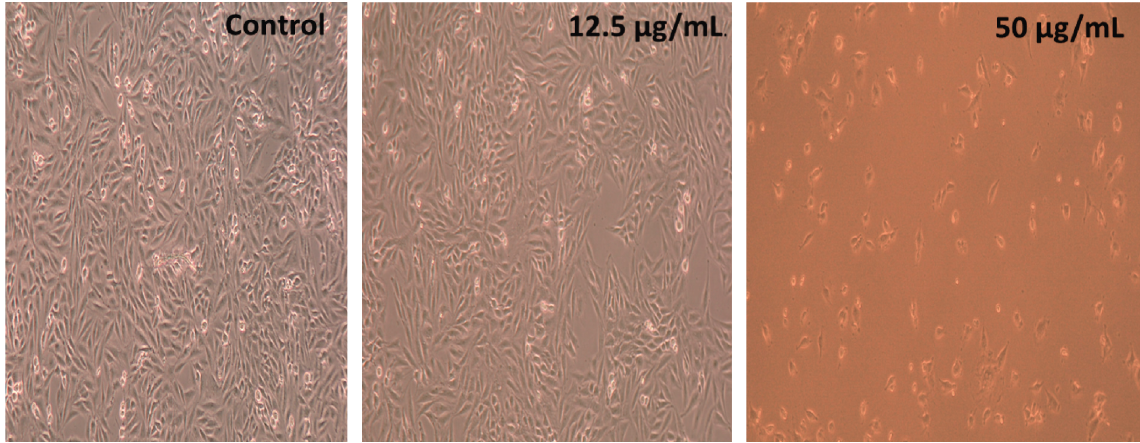
Figure 15: Effect of Ag-NPs concentration on bacterial cell